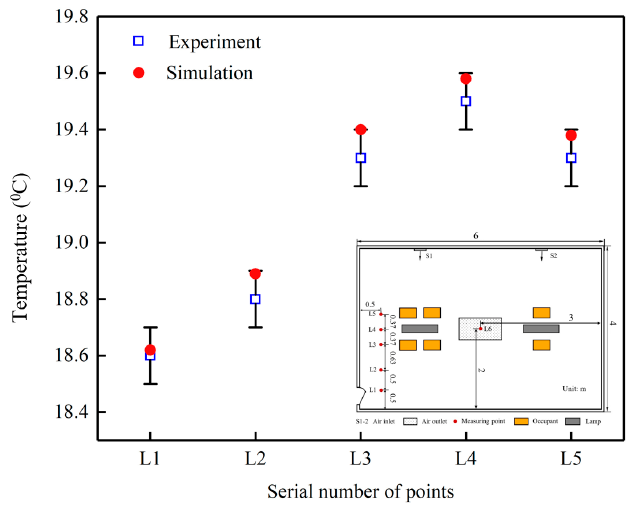
Figure 6. Comparisons of experimental and numerical results of temperature.